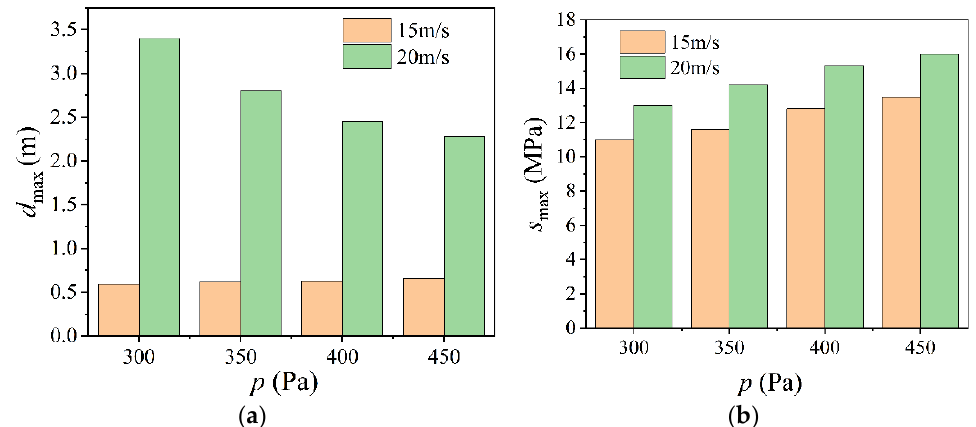
Figure 17. The maximum wind ‐ induced responses with different internal pressures ( L = 60 m, H/L = 0.50, U h = 15 m/s and 20 m/s): ( a ) Displacement; ( b ) Stress.